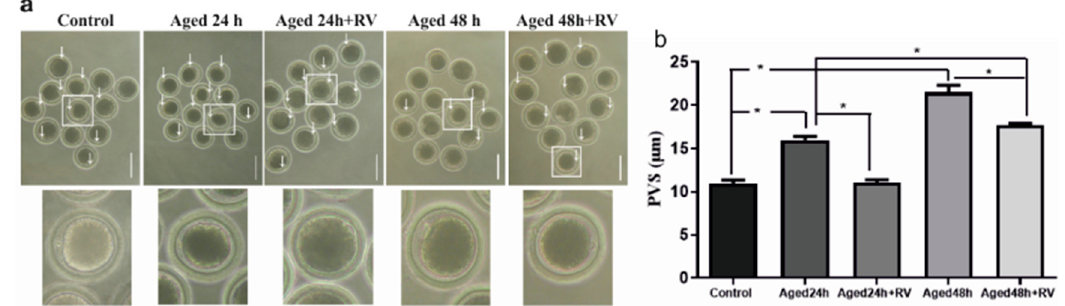
Figure 2. RV suppresses the increasing perivitaline space (PVS) in aged porcine oocytes ( a ) The representative images of perivitaline space in aged porcine oocytes with visible space indicated by white arrows under the microscope, scale bar = 180 μ m. ( b ) The graph indicates the percent increase in perivitaline space after the oocytes treated with 2 μ mol/L RV. Significant difference (* p < 0.05).